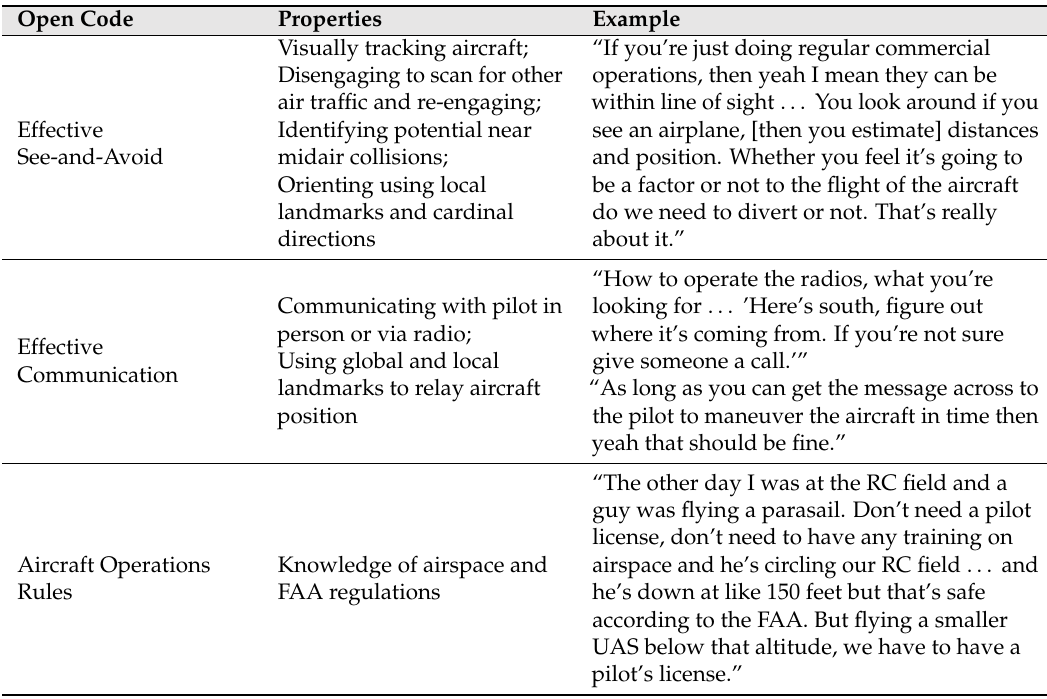
Table A5. Research Question: What are essential skills/knowledge for visual observers?